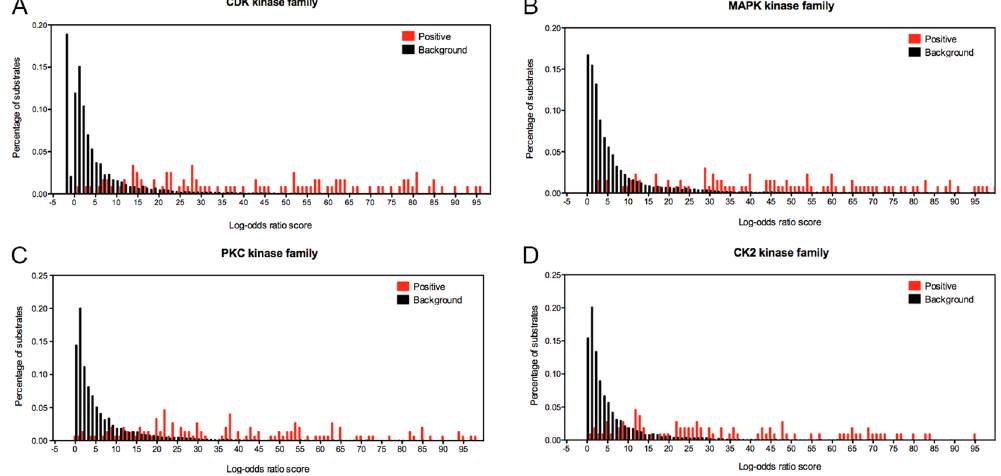
Figure 2. Protein substrate distributions. The distributions of the known protein substrate set (red) and the background protein set (black) for four common kinase families. The x-axis represents the log-odds ratio score, while the y-axis represents the percentage of proteins with the corresponding scores. Data represent ( A ) CDKs, ( B ) MAPKs, ( C ) PKC, and ( D ) CK2.